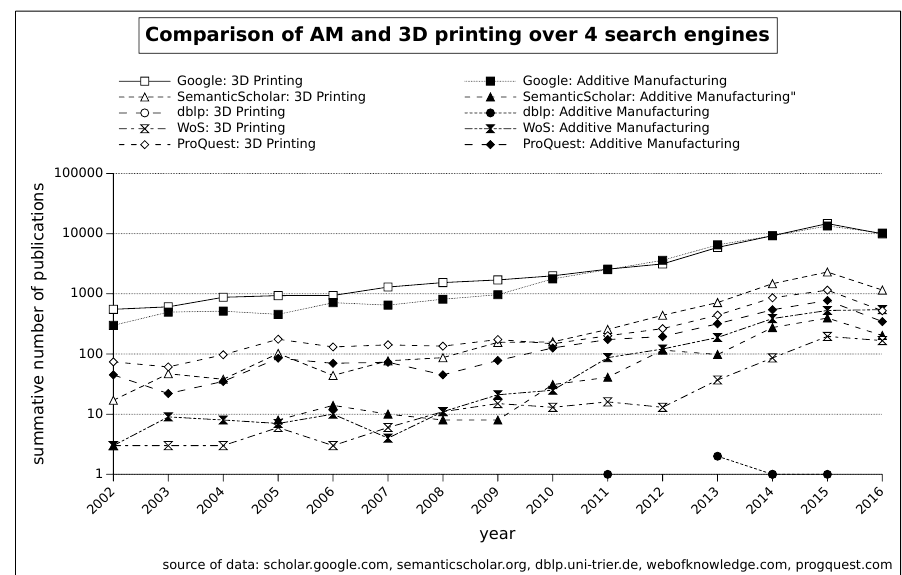
Figure 8. Comparison of AM and 3D Printing using selected search engines (2002–2016).